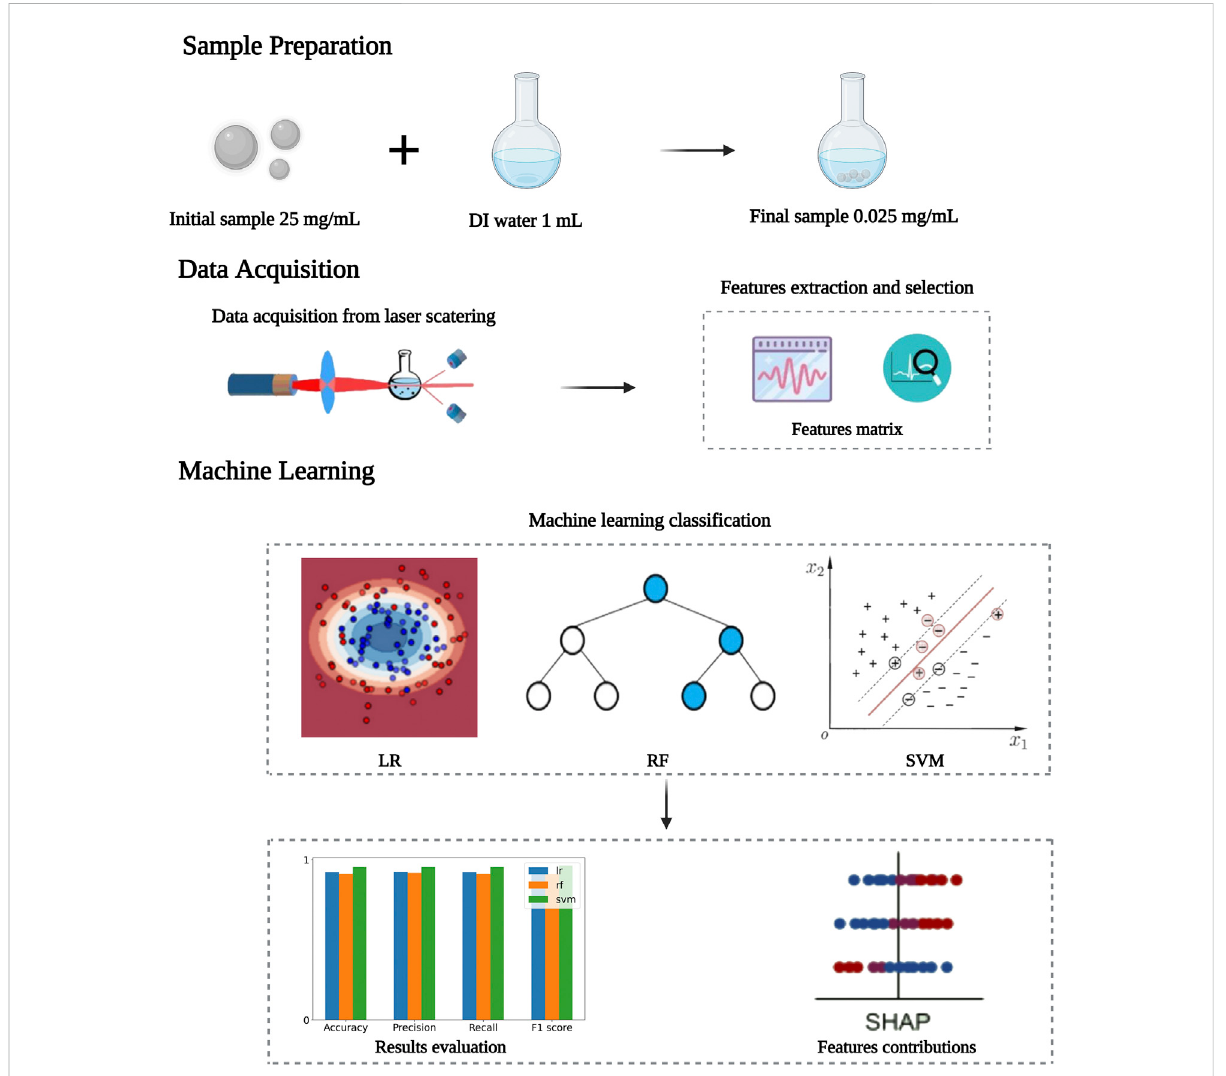
FIGURE 1 The fl owchart for the detection principle for classifying microparticles based on MDLS and machine learning.